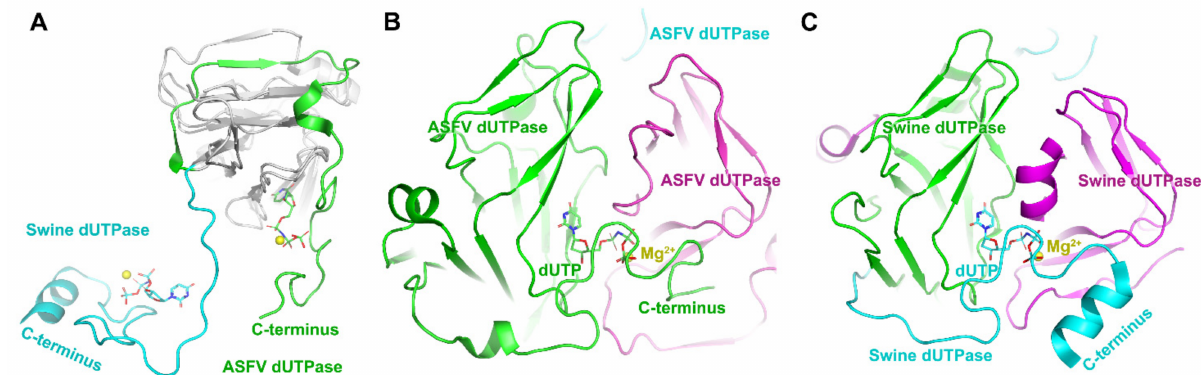
Figure 3. Structures of ASFV dUTPase and swine dUTPase. ( A ) Subunit superimposition of ASFV dUTPase (pdb: 6LJ3) and swine dUTPase (pdb: 6LJJ) [31]. ( B ) The novel two-subunit active sites in ASFV dUTPase. ( C ) The classical three-subunit active sites in swine dUTPase. Different subunits are indicated by different colors. The C-terminus is highlighted. The dUTP is indicated as sticks and colored by element. The magnesium ion is indicated by the yellow